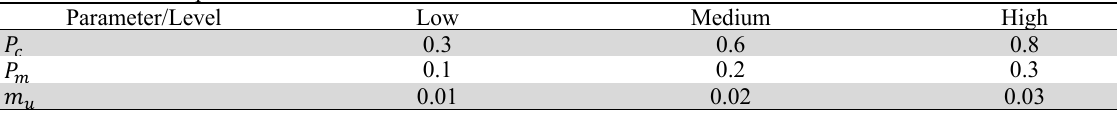
The levels of the GA parameters Parameter/Level Low Medium High 𝑃 (cid:3030)